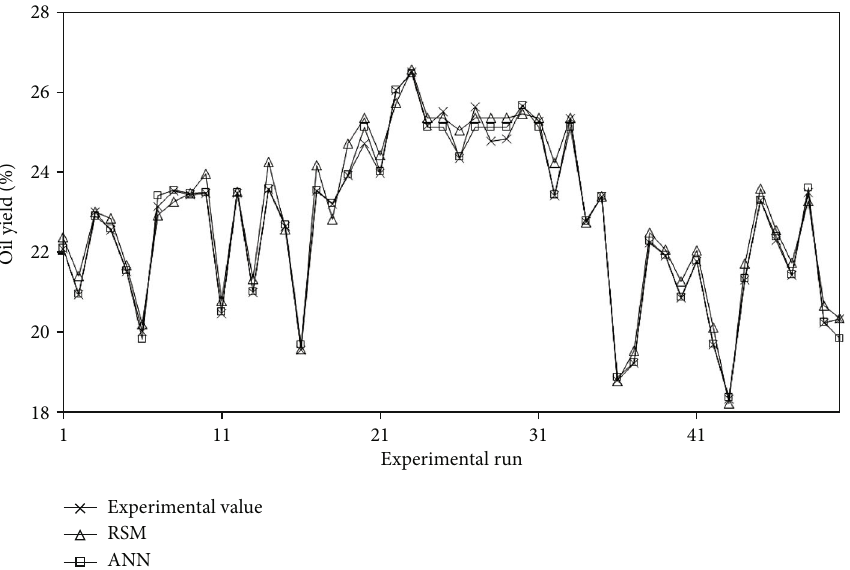
Figure 3: Comparison of experimental, predicted values of RSM and